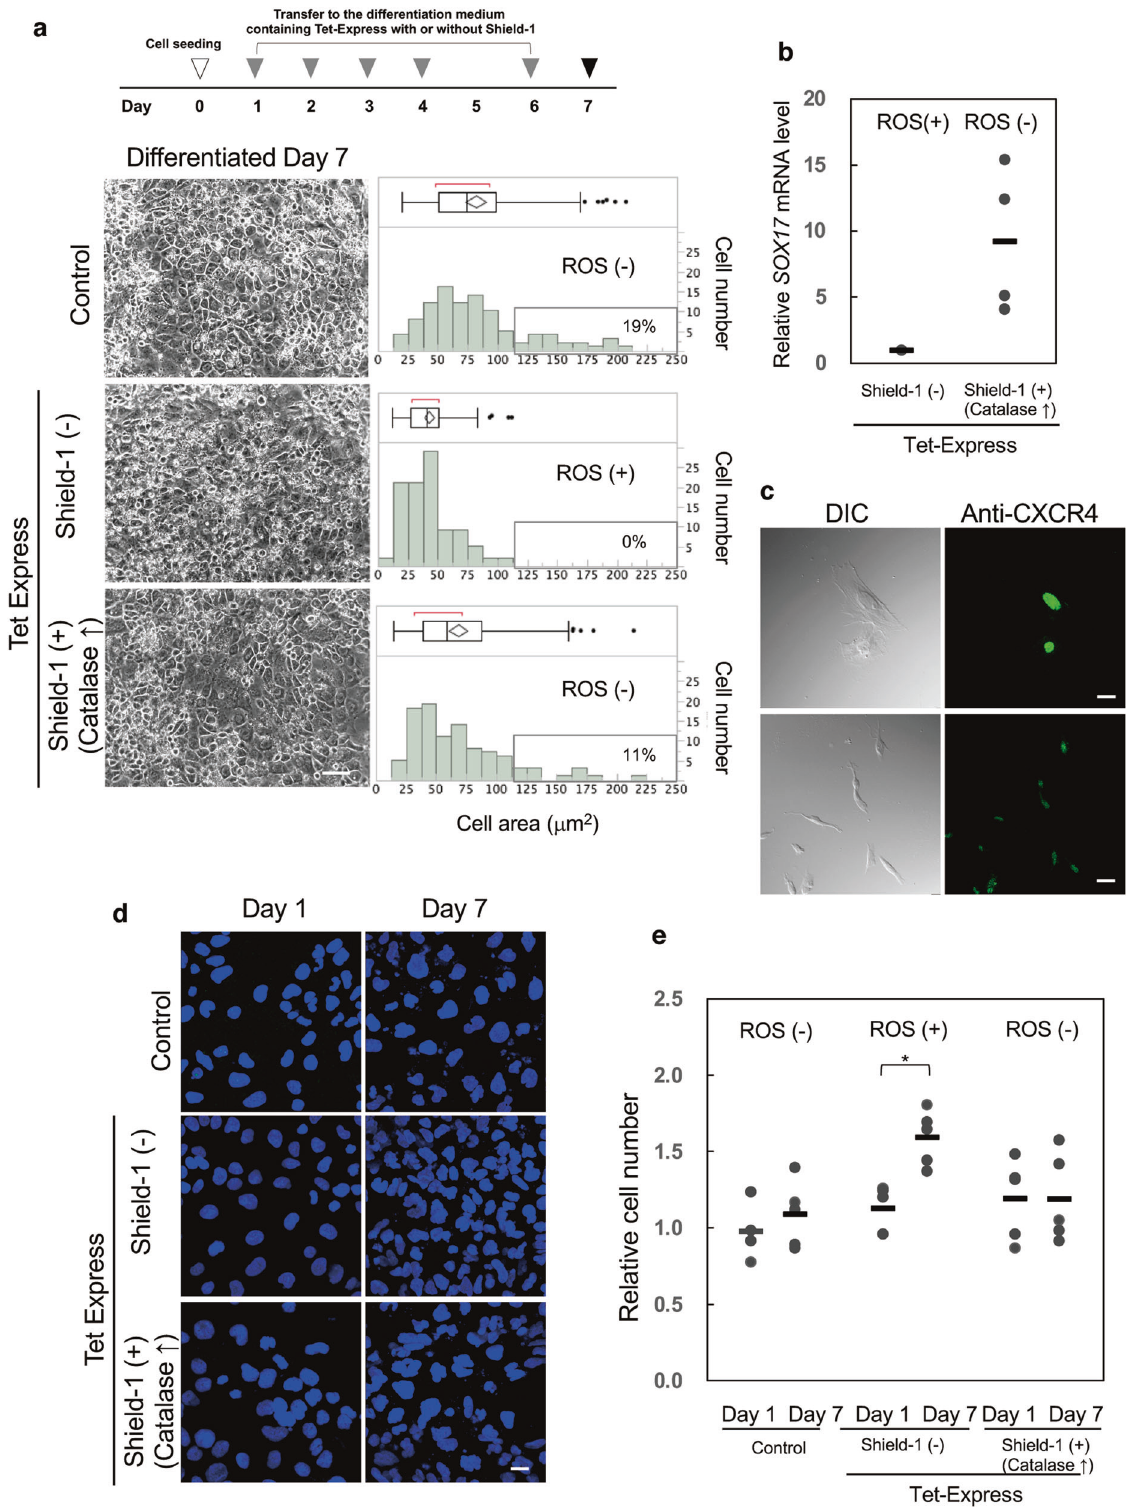
In the present study, expression of the transcription factor FOXC1 containing a characteristic DNA-binding forkhead domain was transiently increased by ROS production in the initial stage of differentiation, and mitochondrial-targeted catalase prevented its elevation. Moreover, transient expression of FOXC1 in the early Cell Death Discovery (2022)